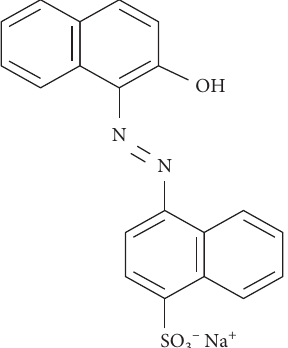
Figure 2: The 2D structure of AR88.